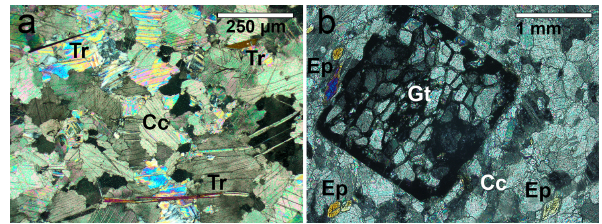
Figure 4. Micrographs (crossed polars) of marbles at the contact between Permian limestone and blueschist, northeast of Rongma; (a) deformed and dynamically recrystallised calcite (Cc) with aligned needles of tremolitic amphibole (Tr); (b) calcite marble with epidote (Ep) and post-tectonic poikiloblastic garnet (Gt).